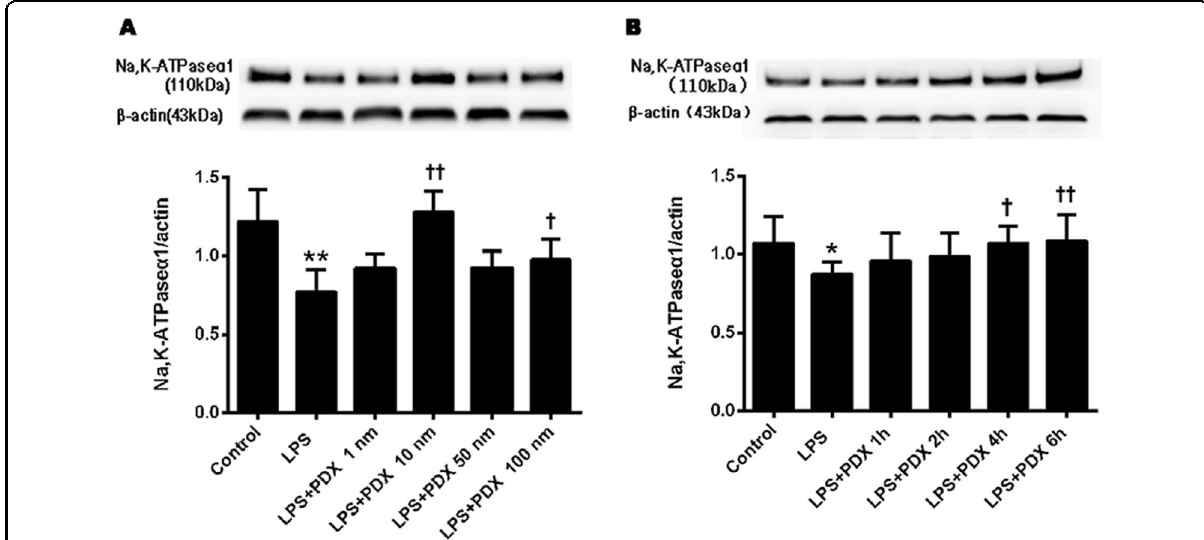
Fig. 5 Dose and time dependency of protectin DX regulation of Na, K-ATPase expression in primary ATII cells. The dose- and time- dependent changes in Na, K-ATPase protein expression levels in primary ATII cells stimulated with LPS (1 µg/ml) were determined by western blotting. Cells were incubated for 6 h with different concentrations of protectin DX, including 3.605 × 10 − 4 , 3.605× 10 − 3 , 18.025 × 10 − 3 , and 3.605 × 10 − 1 mg/l, to measure Na, K-ATPase α 1 subunit protein expression levels ( a ). Moreover, ATII cells were incubated with LPS (1 µg/ml) for 1, 2, 4, and 6 h to detect Na, K-ATPase α 1 subunit protein expression levels ( b ). The data are presented as the mean ± SD. n = 8. PDX protectin DX. * p < 0.05, ** p < 0.01 versus the control group; † p < 0.05, †† p < 0.01 versus the LPS